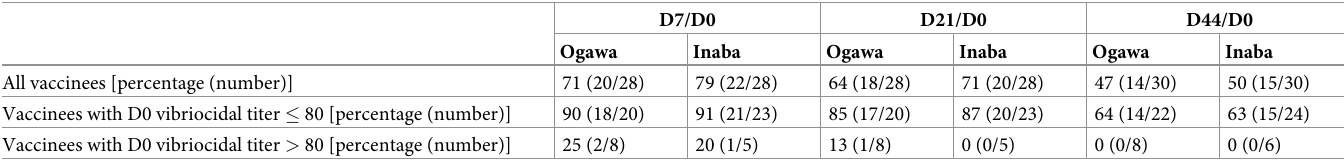
Table 2. Vibriocidal seroconversion (percentage and number) in adult